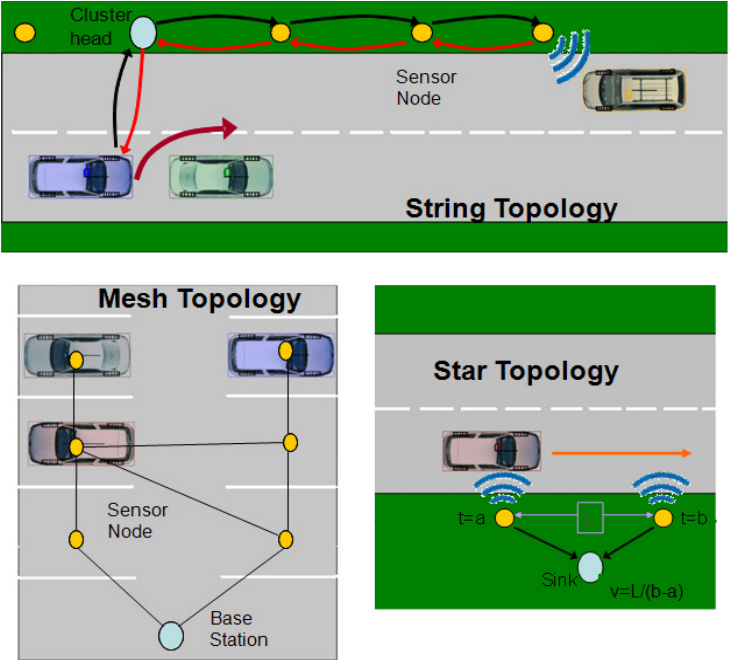
Figure 3. Sensing topologies and examples: (a) String topology, overtaking